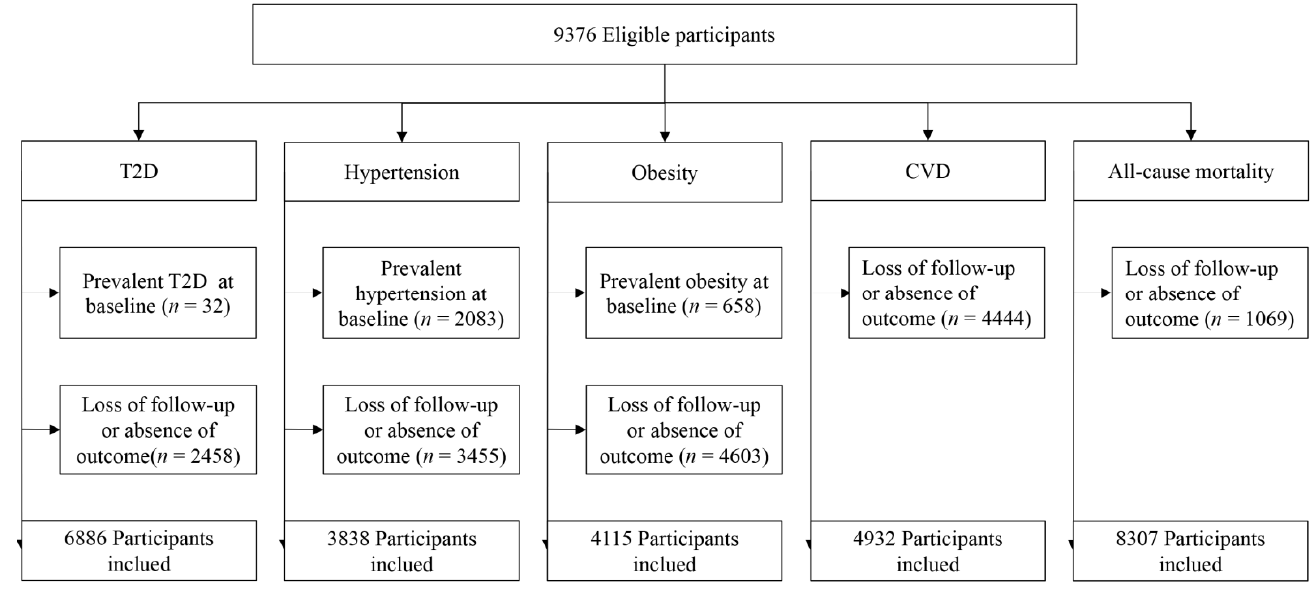
Figure 1. Participants flowchart.